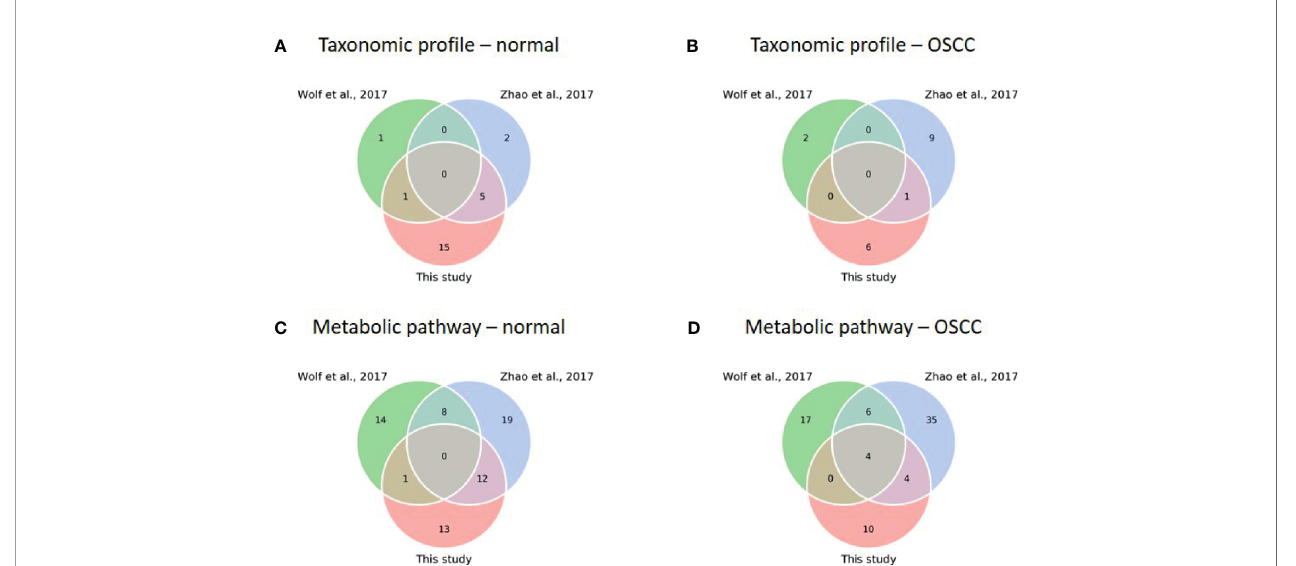
FIGURE 6 | Comparison of diversity and core analysis between taxonomic and functional pro fi les from this study and previous studies (Wolf et al., 2017; Zhao et al., 2017). (A – D) Venn diagrams reveal common core species/pathways (prevalence > 75%) in normal and OSCC cohorts, respectively. (Taxonomic pro fi les of normal (A) and OSCC (B) cohorts; metabolic pathway pro fi les of normal (C) and OSCC (D)